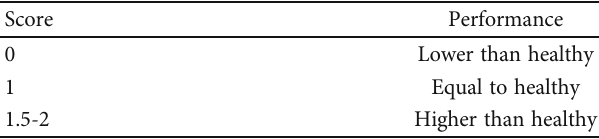
Table 1: Performance score for each treatment per animal.